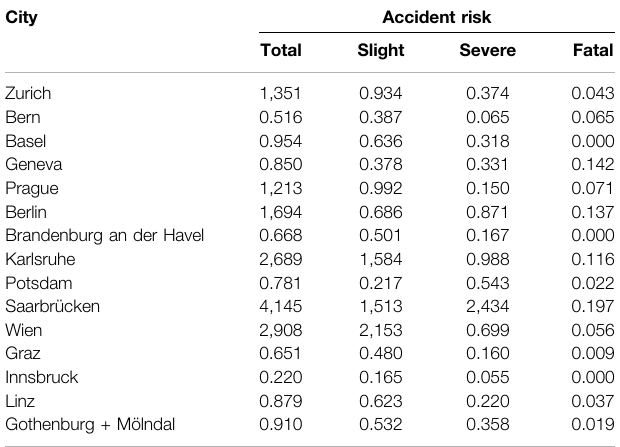
TABLE 2 | Risk estimates for each city.